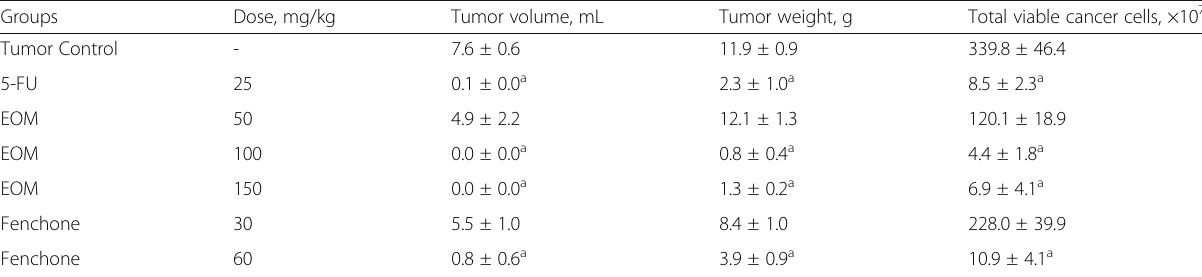
Table 4 Effects of EOM, fenchone and 5-FU on tumor volume, weight, and total viable cancer cells in mice ( n =6) transplanted with Ehrlich ascites carcinoma cells subjected to different treatments (9 days) Groups